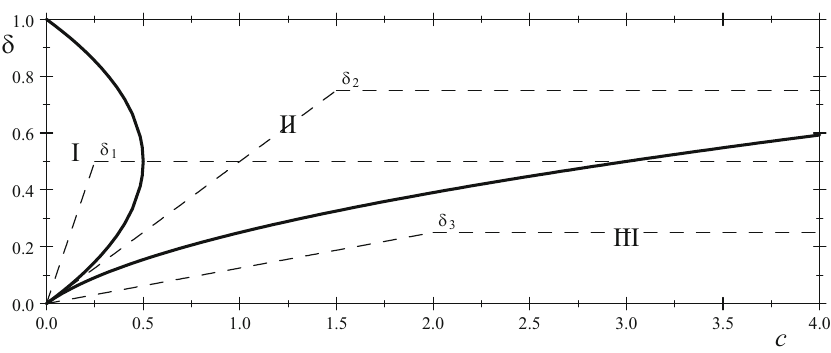
Fig. 7 Technologies for which complete, star and empty networks are